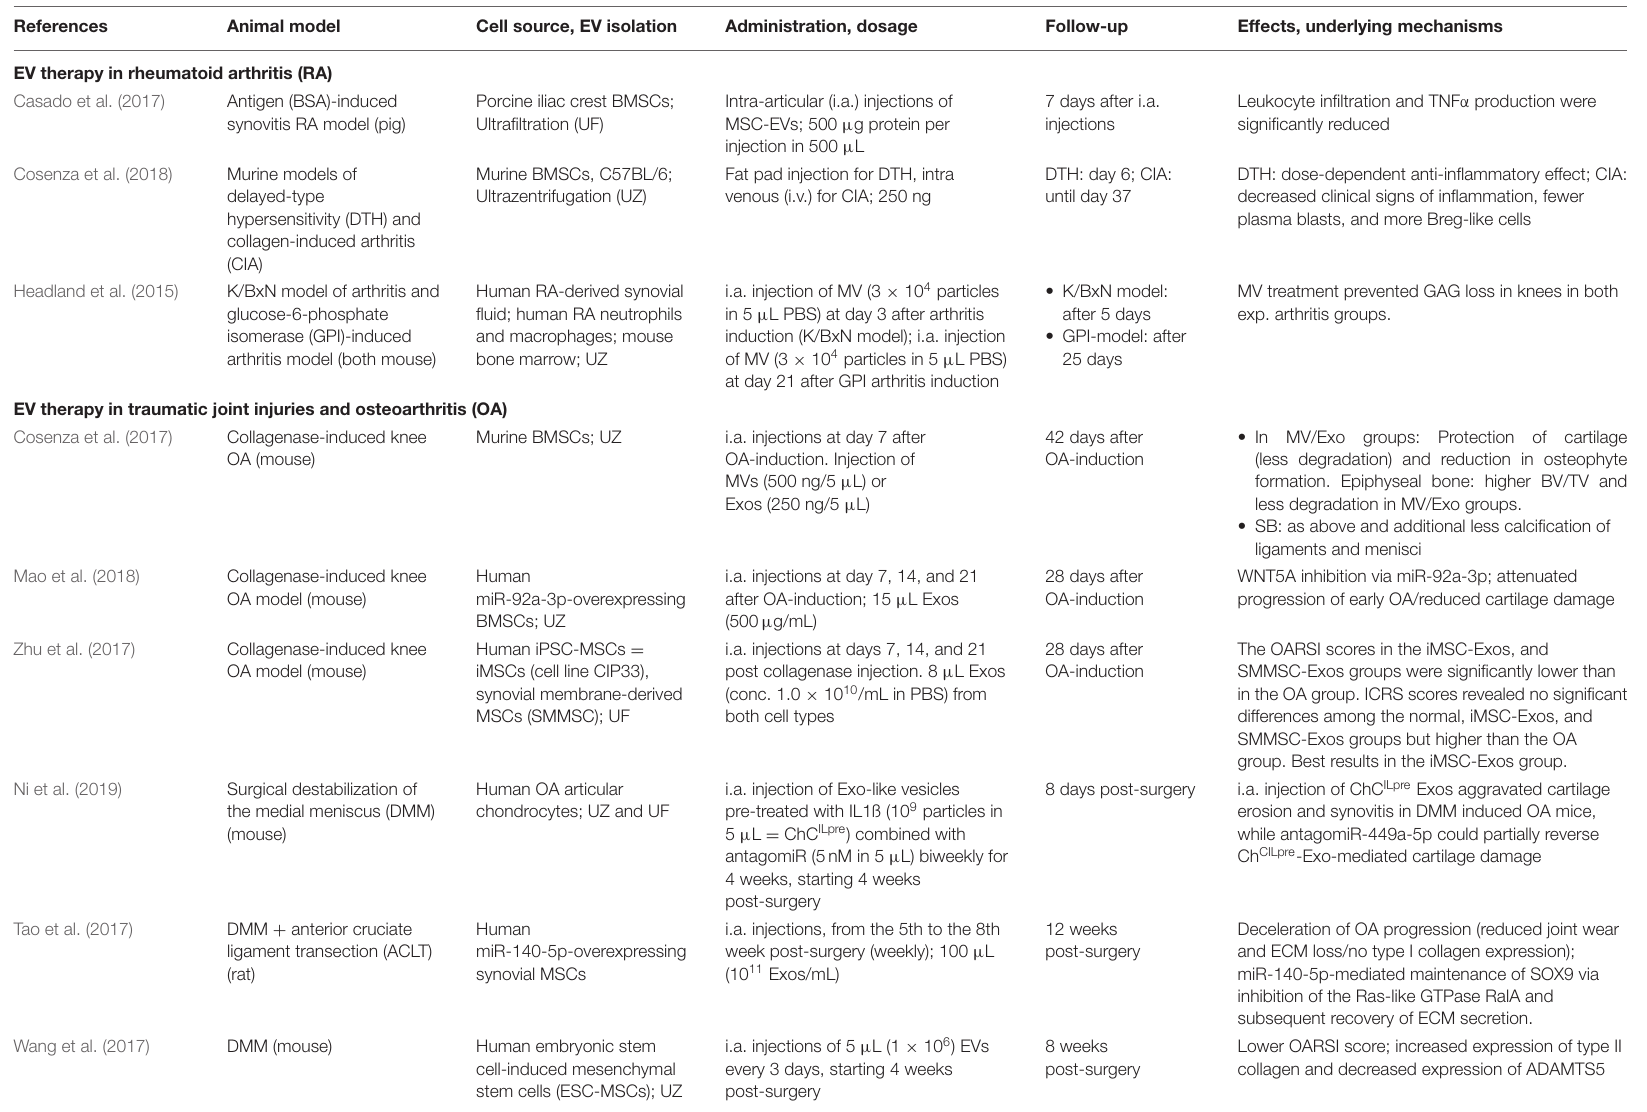
TABLE 1 | Summary of preclinical studies testing the therapeutic application of MSC-EVs in musculoskeletal